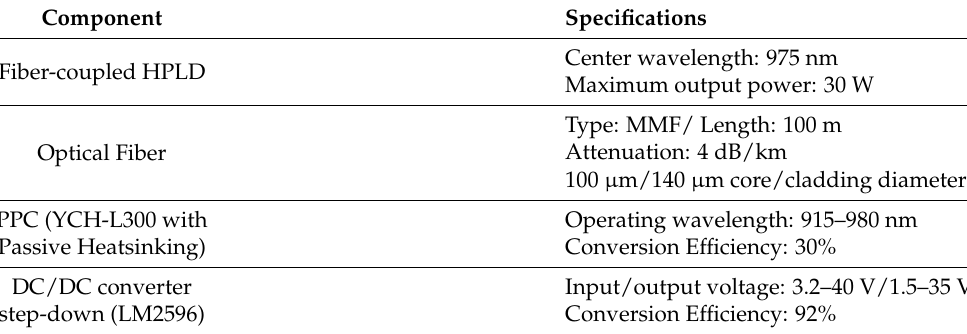
Figure 3. PoF system experimental implementation: ( a ) With the DC/DC converter. ( b ) Without the DC/DC converter. HPLD—high-power laser diode; MMF—multimode fiber; PPC—photovoltaic power converter. Table 2. PoF System